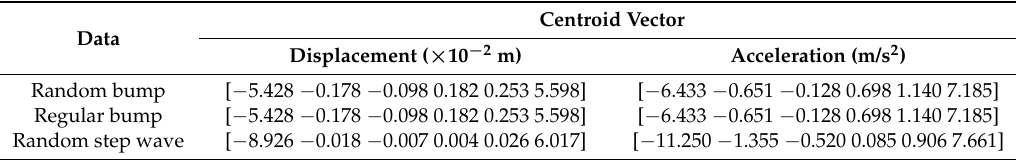
Table 4. Centroid vectors of fuzzy rules using Gaussian